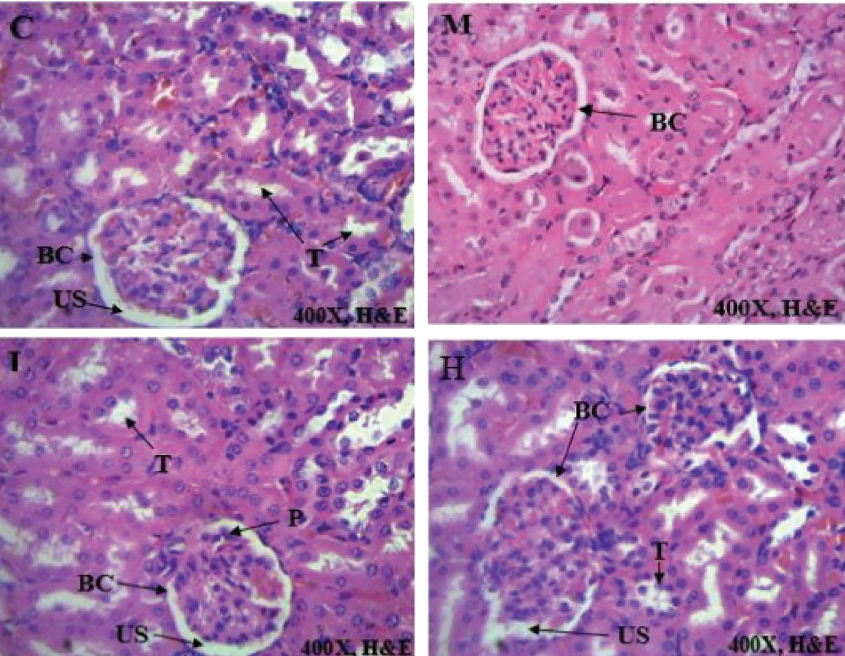
Figure 3: Efect of AAE on histological features of the kidney. C control, L 100mgkg − 1 , M 300mgkg − 1 , and H 1000mgkg − 1 . BC- Bowman’s capsule, US- urinary space, T-tubule, and P- nucleus of podocytes. Te photomicrographs (H&E, x400) of the kidney tissues represent the general appearance observed in the rats dosed with AAE and the control group.